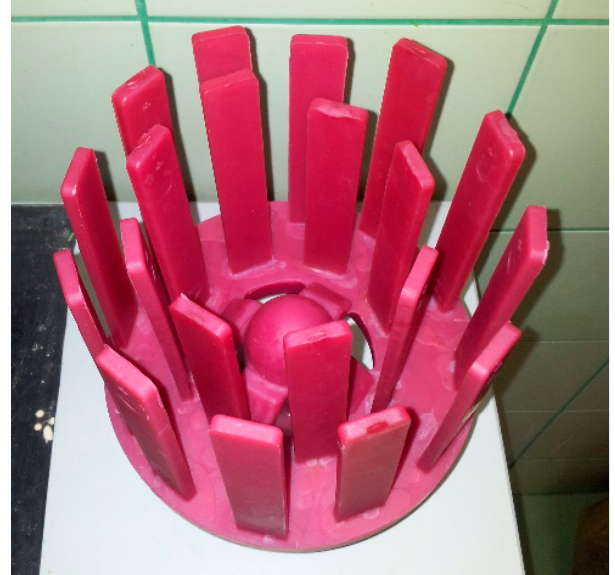
Figure 1. Example image of wax-assembled pattern for the fabrication of SiC-based shell molds using an immersion-sprinkling method.